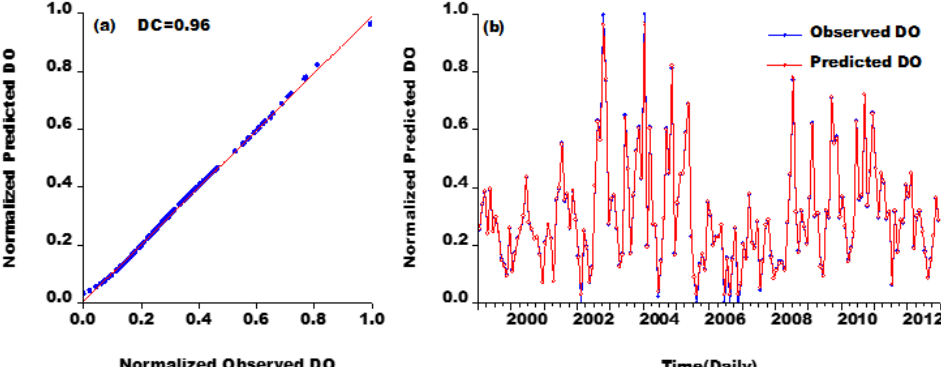
Fig. 6: Evaluation of ANFIS model a) scatter plot (b) observe versus computed time series of DO (Tables 4 and 5). In contrast, MLR computed values are deviated more from the observed values MLR performance efficiency shown in Table